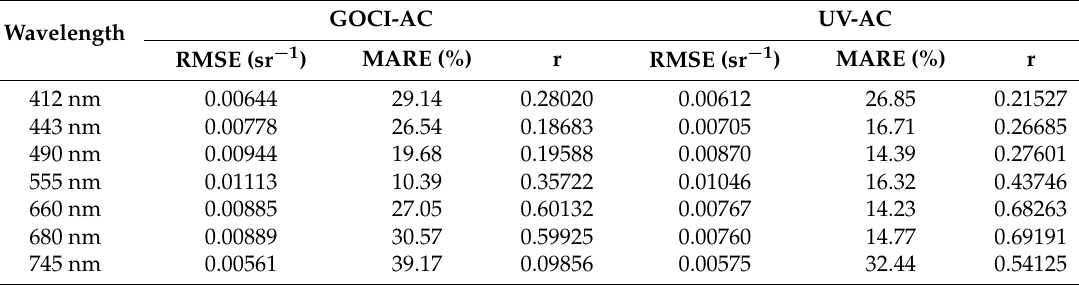
Table 3. Comparative results between the satellite-derived R rs calculated with two atmospheric correction algorithms and in-situ measured R rs .